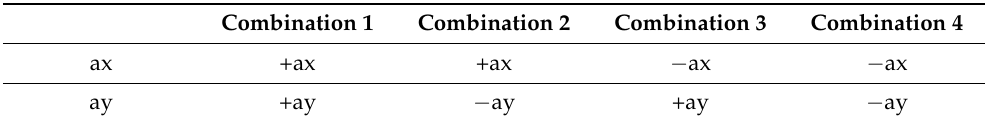
Table 4. Seismic load combinations used in NLS.